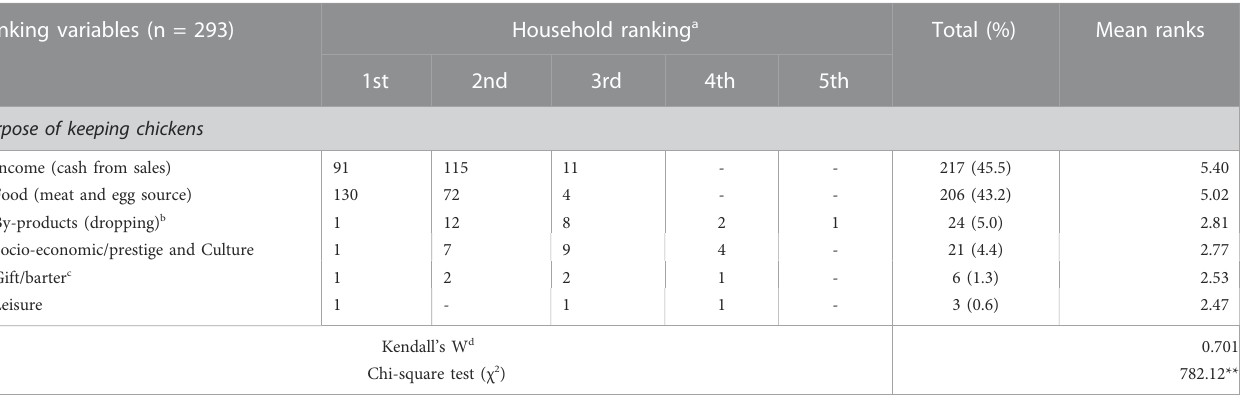
TABLE 3 Reasons/purposes for keeping